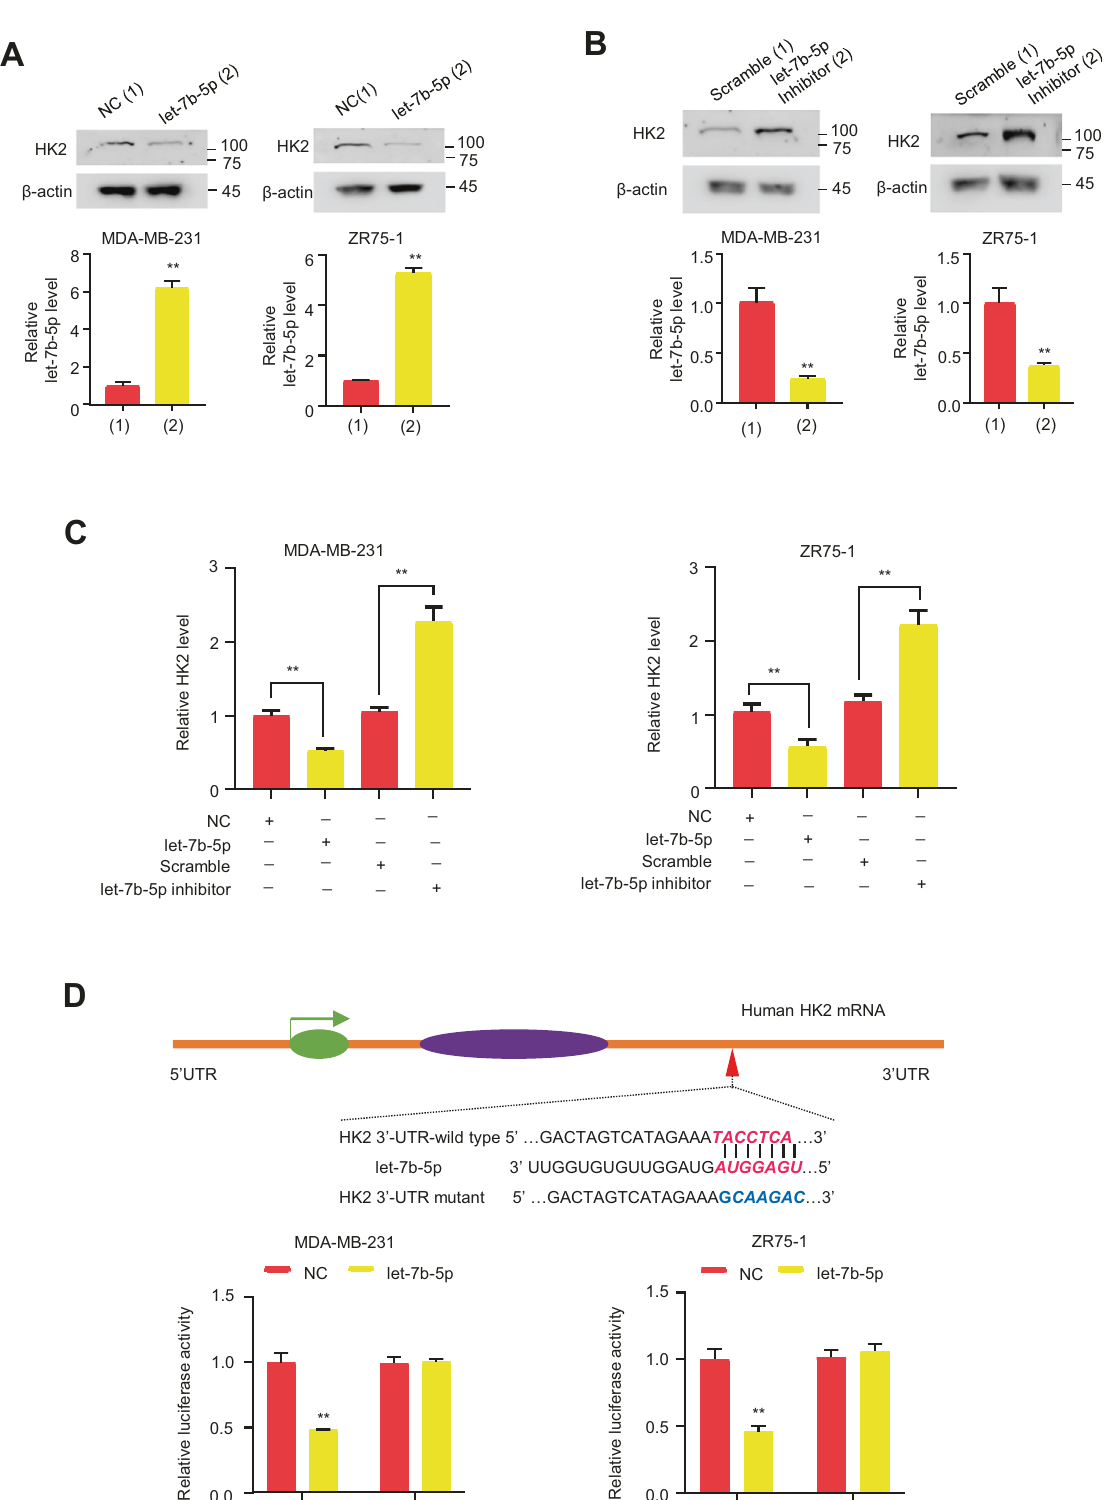
Fig. 2 Let-7b-5p targets HK2. A , B Western blot for HK2 protein expression in indicates BC cells after transfection with let-7b-5p mimic or NC ( A ) or let-7b-5p inhibitor or scramble ( B ) ( n = 3, mean ± SD). Histograms under western blot show let-7b-5p expression by RT-qPCR ( n = 3, mean ± SD). C RT-qPCR assay of HK2 mRNA expression level in indicated BC cells after transfection with let-7b-5p mimic/inhibitor ( n = 3, mean ± SD). D Dual-luciferase reporter assay of the indicated BC cells after transfection with wild-type or mutated HK2 reporter plus let-7b-5p mimic ( n = 3, mean ± SD). The top panel shows the putative binding sites between HK2 and let-7b-5p. ** p < 0.01 versus corresponding